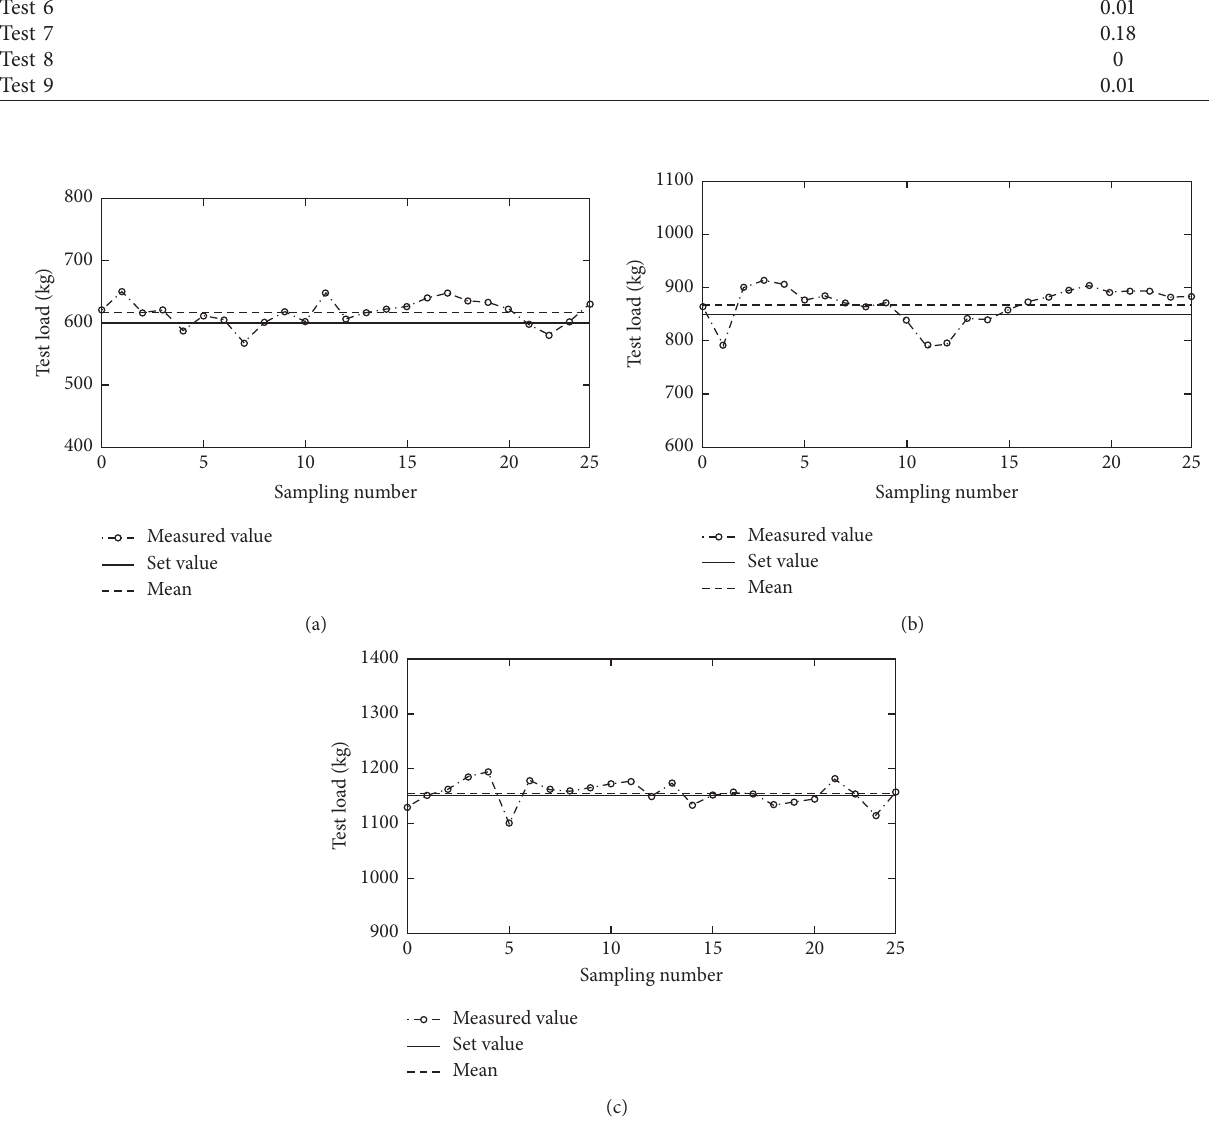
Figure 16: Test load measurement and mean curve: (a) test 1; (b) test 2; (c) test 3.